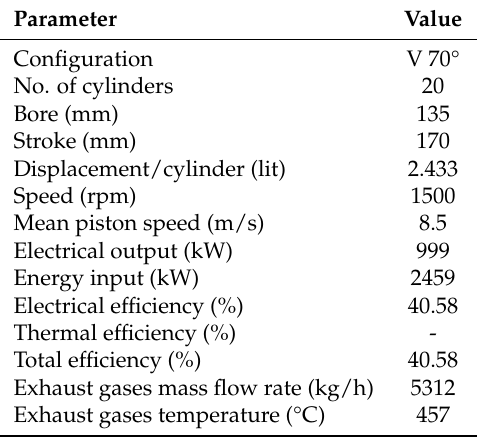
Table 1. Engine technical